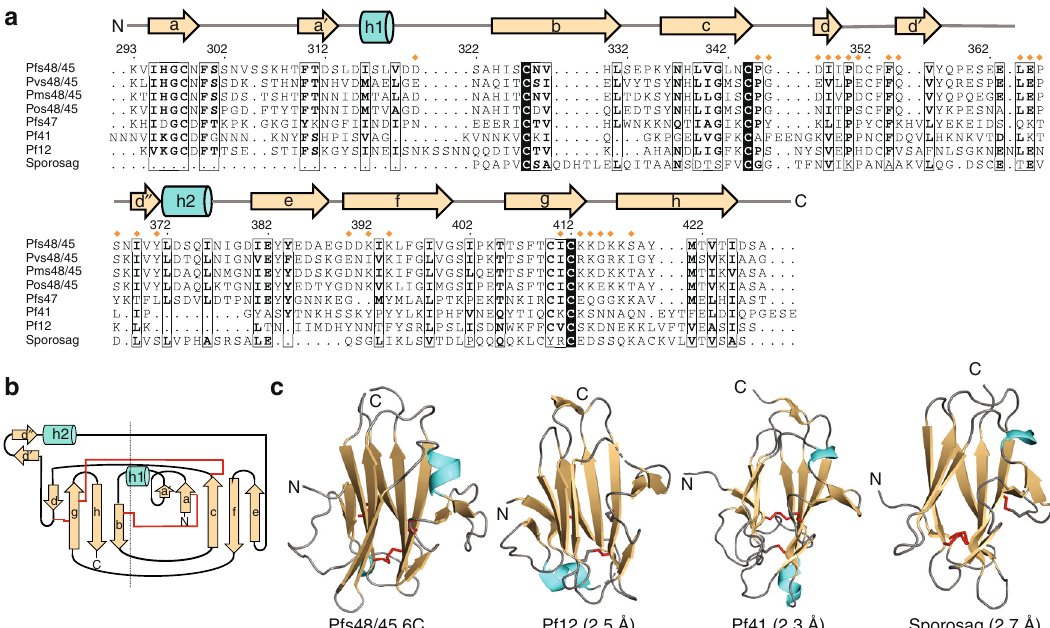
Fig. 2 Sequence similarity and structural homology of Pfs48/45 6C. a Sequence alignment of Pfs48/45 6C with proteins of highest sequence identity (Pvs48/45, Pms48/45, Pos48/45, and Pf47) and structural homology (Pf12, Pf41, and Sporosag). Secondary structure elements of Pfs48/45 6C are shown atop the sequence alignment, with an arrow and a cylinder indicative of a strand and a helix, respectively. Orange dots above the Pfs48/ 45 sequence indicate residues contacted by mAb 85RF45.1. b Schematic diagram of Pfs48/45 showing a fi ve-on-four ß sandwich disposition with parallel and anti-parallel ß-strands. Disul fi de bonds are indicated by red lines. c Secondary structure cartoon representation of Pfs48/45 6C in comparison to known structures of highest homology (PDB IDs: 2YMO [https://www.rcsb.org/structure/2YMO] 55 , 4YS4 [https://www.rcsb.org/structure/4YS4] 56 , 2WNK [https://www.rcsb.org/structure/2WNK] 57 ). Disul fi de bonds are represented as red sticks. Root mean square deviations (rmsd) between Pfs48/ 45 and the structures as calculated by the DALI server 31 are indicated in